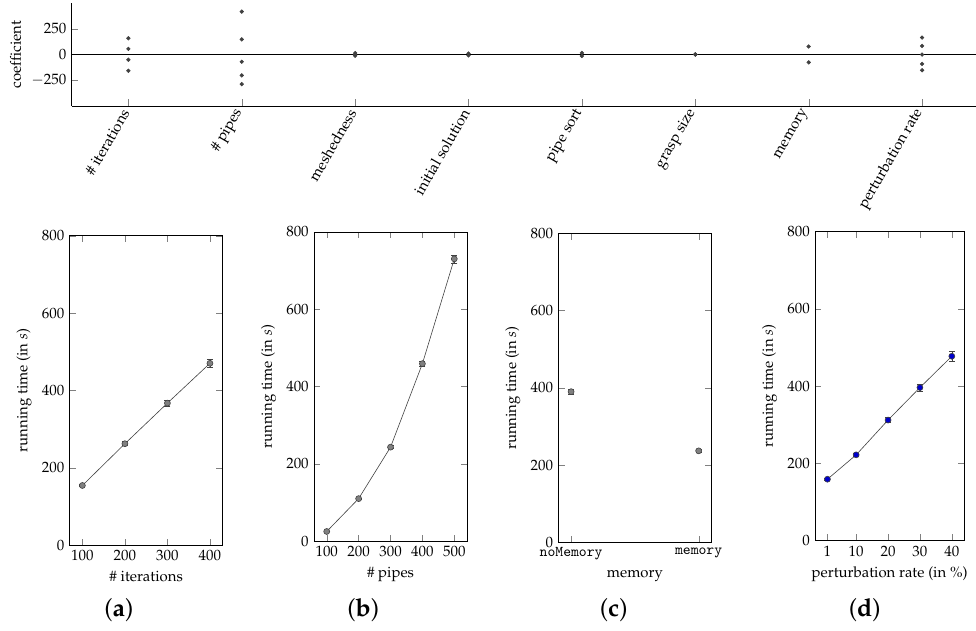
Figure 8. Values of the coefficients and mean plots for the regression model on the running time : main effects.